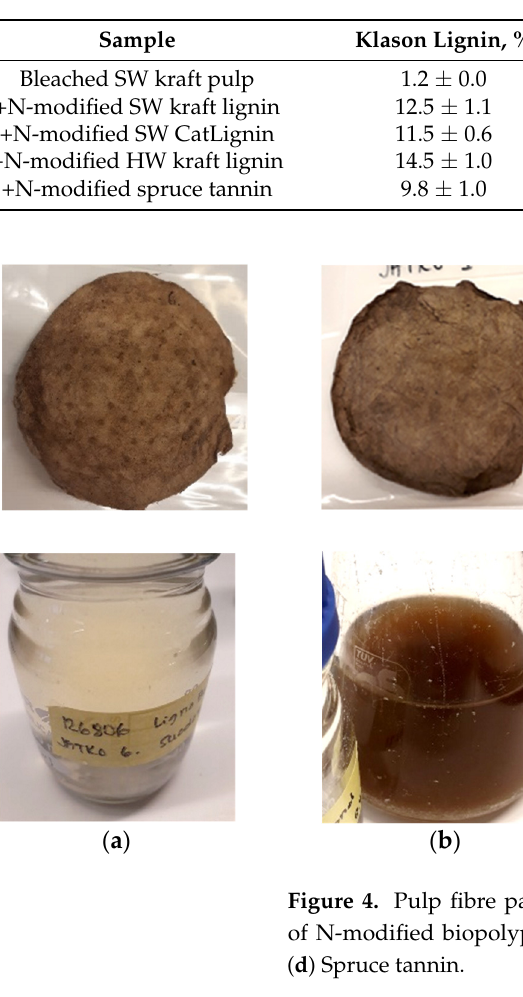
Table 4. Chemical analysis of samples made with the Tanfloc SG 2.5% and A-PAM 0.45% retention system.